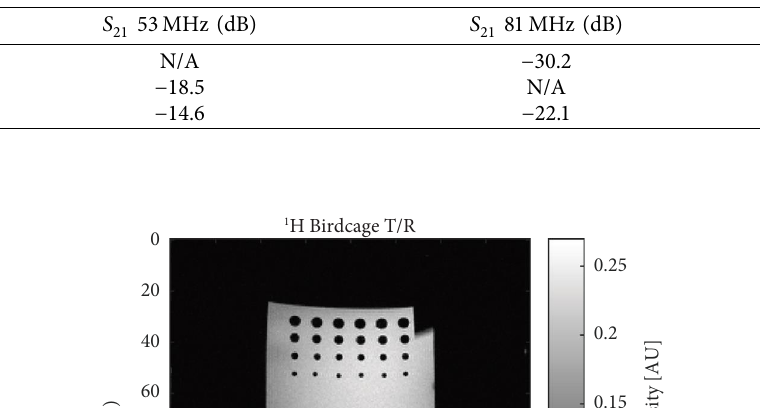
Table 5: Triple-tuned birdcage/saddle decoupling measurements.